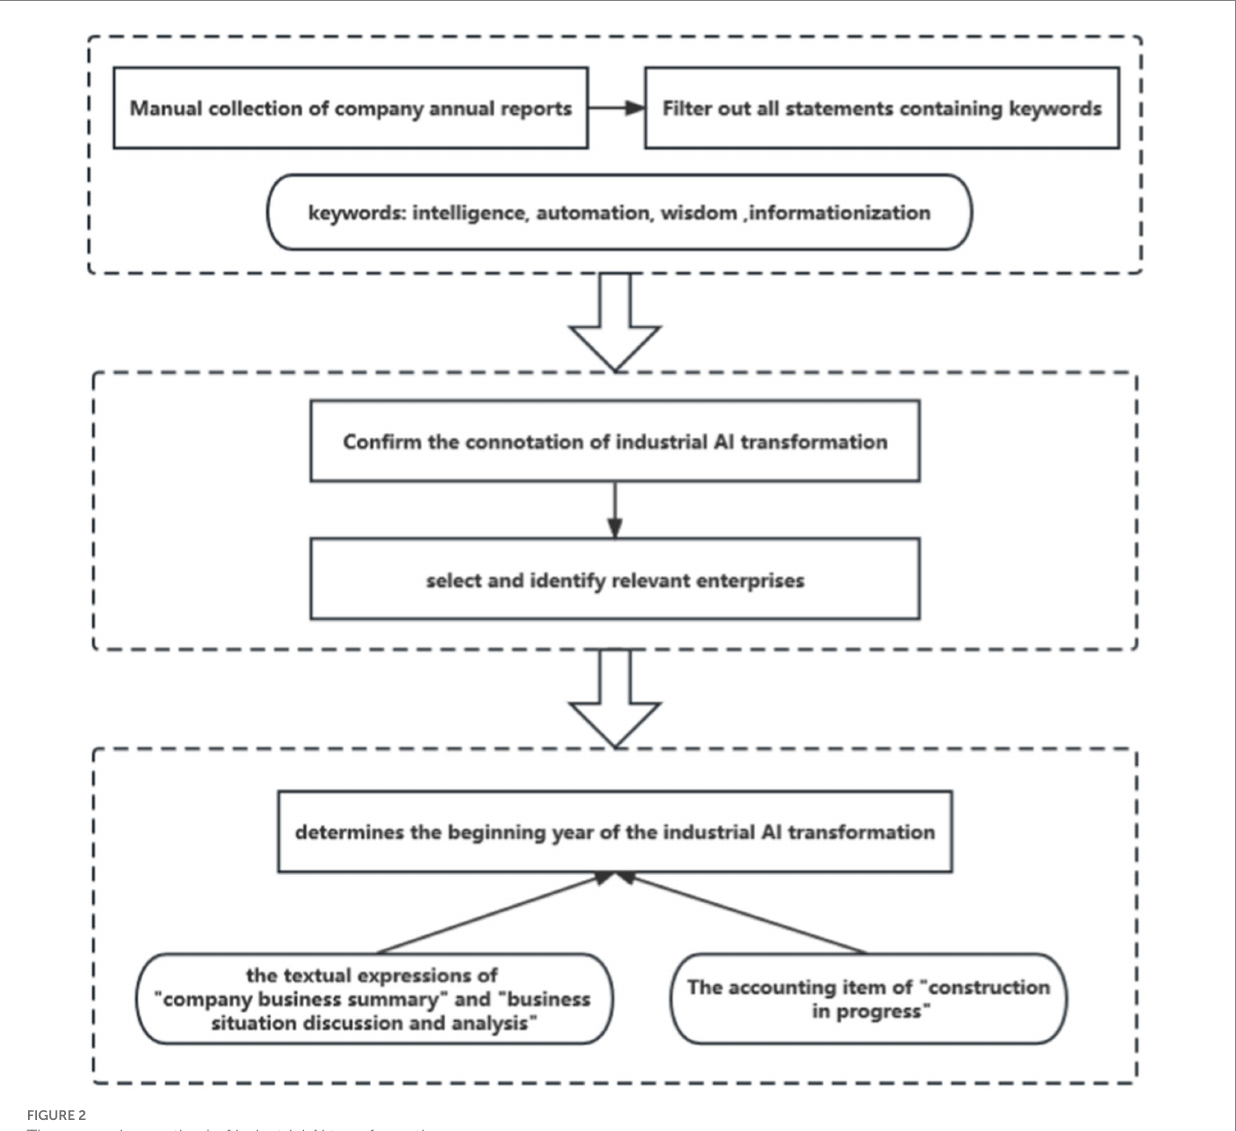
FIGURE 2 The measuring method of industrial AI